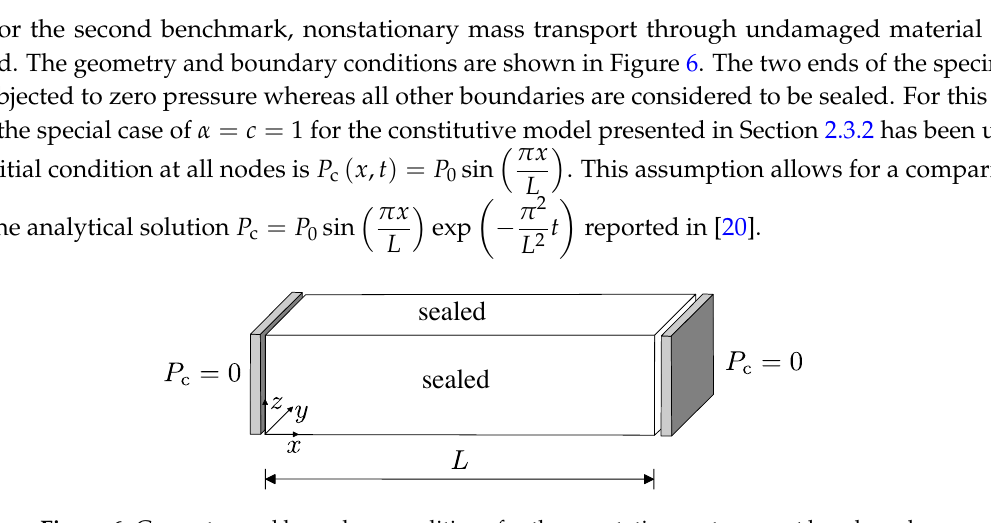
Figure 6. Geometry and boundary conditions for the nonstationary transport benchmark. Three transport networks with minimum distances between Delaunay vertices of d min / L = 0.06, 0.045 and 0.03 are used. The coarse network with d min / L = 0.06 is shown in Figure 7.